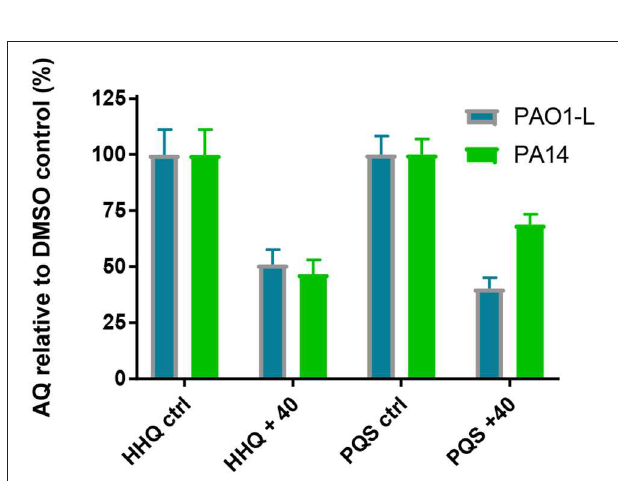
FIGURE 4 | Pyocyanin production by Pseudomonas aeruginosa after treatment with pqs inhibitors 8, 14, 23, 34, 25, 26, and 40 . Quantification of pyocyanin production after inhibitor treatment at 3 × IC 50 for both PAO1-L and PA14. The graph represents the average of three independent experiments carried out in triplicate ( n = 9 ).